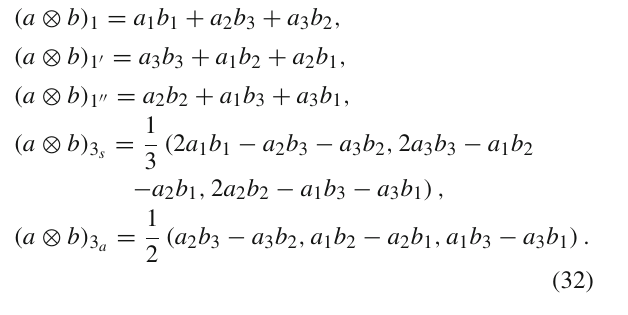
3 ⊗ 3 = 1 ⊕ 1 (cid:8) ⊕ 1 (cid:8)(cid:8) ⊕ 3 s ⊕ 3 a